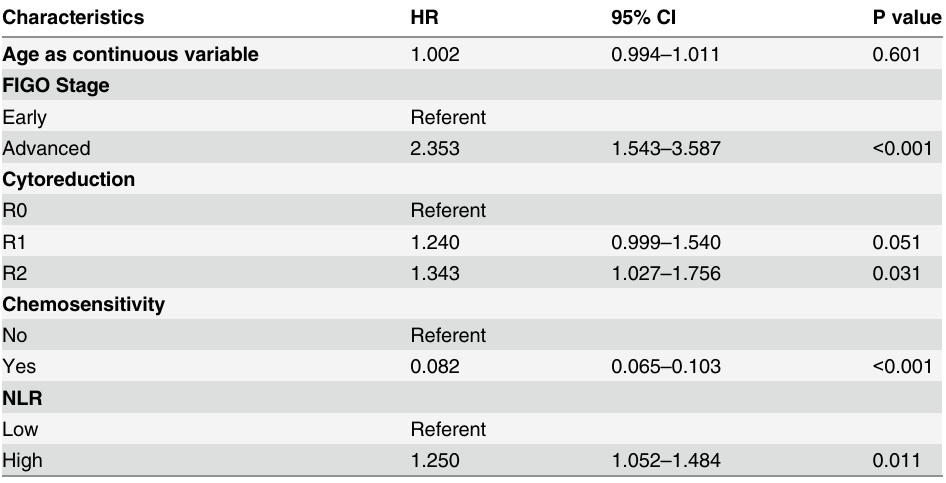
Table 3. Multivariable analysis of factors associated with PFS.